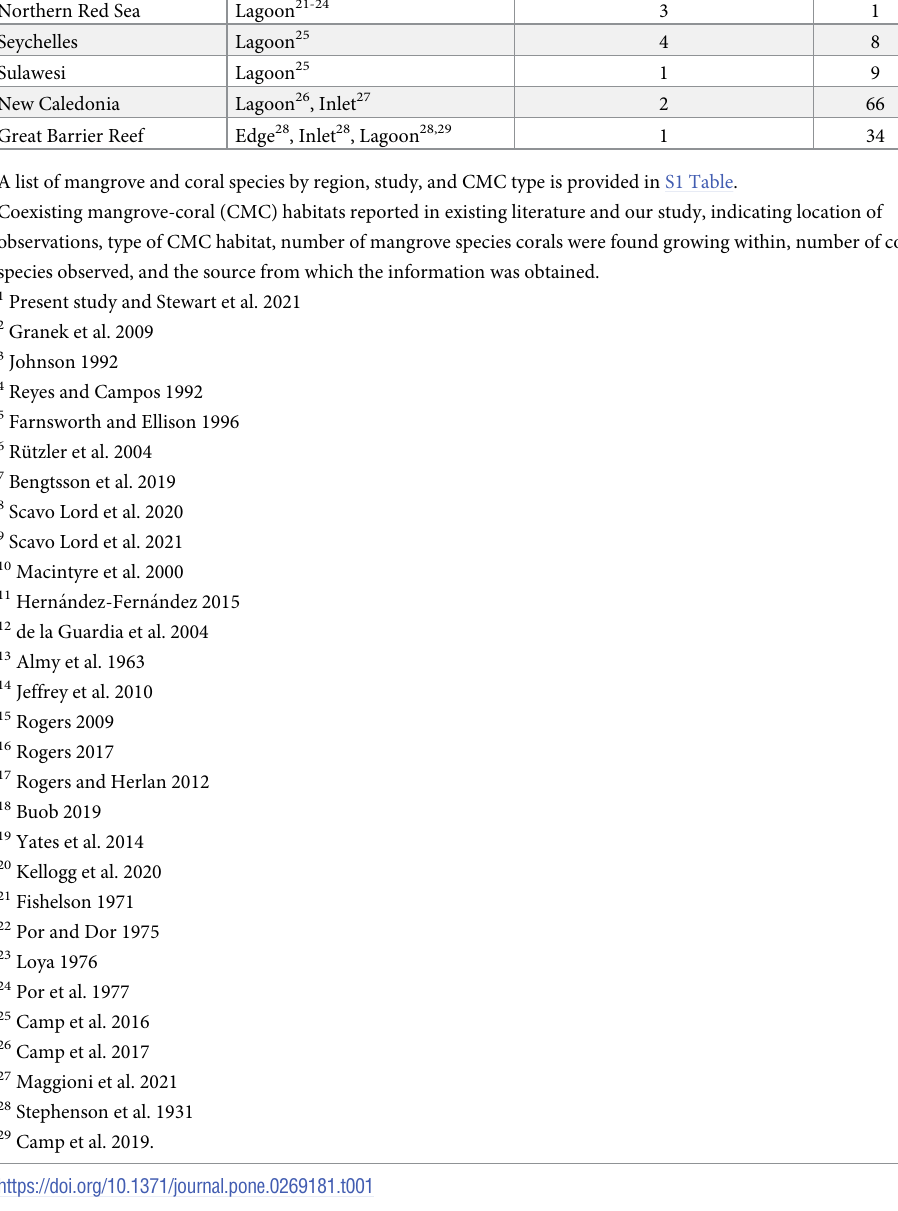
Table 1. Coexisting mangrove-coral (CMC) habitat types and richness of mangrove and coral species by region.